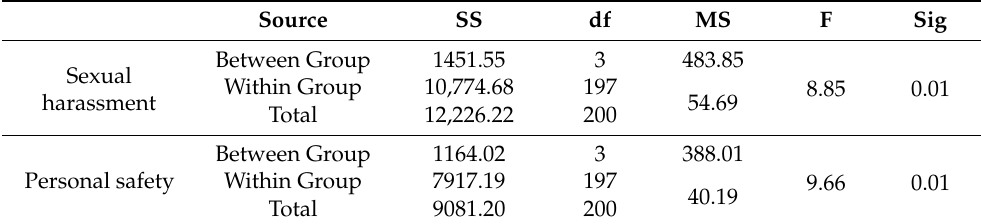
Table 11. ANOVA output for fear of sexual crime and personal safety by marital status. Source